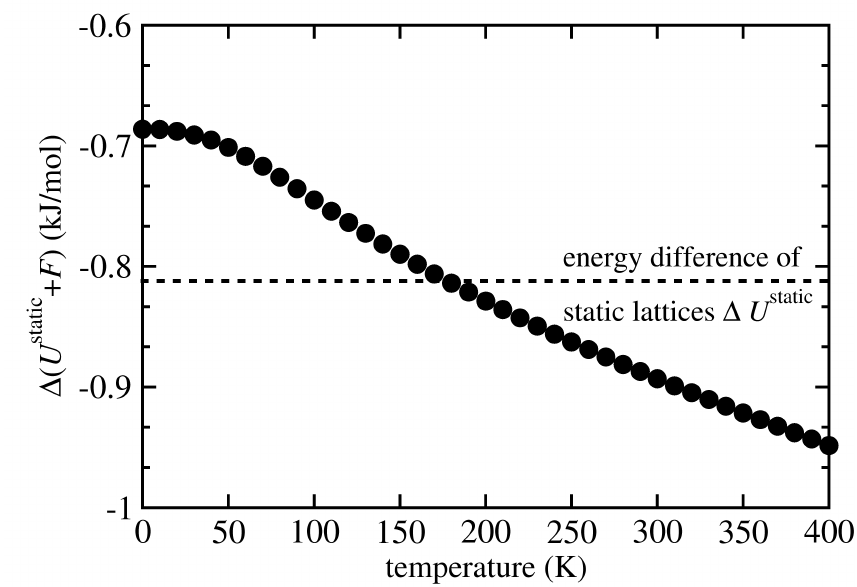
Figure 6. Calculated segregation-related energy difference (per 64-atom supercell) that includes both the static lattice energy U static and the phonon free energy F . The difference is between the states with (i) two Cu atoms at the APB interfaces and (ii) far away from them as a function of temperature. It is compared with the segregation-related energy difference of static lattices ∆ U static (see horizontal dashed line). As one mol, we mean one mol of 64-atom